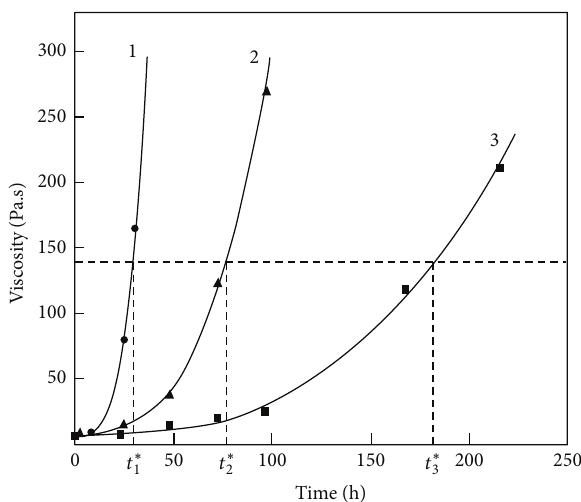
Figure 7: Dynamic viscosity variation of epoxy-anhydride compositions at T = 25 ∘ C versus time in the presence of catalysts: (1) 2,4,6- tris(dimethylaminomethyl)phenol; (2) methylimidazole; (3) 1-butyl-3-methylimidazolium